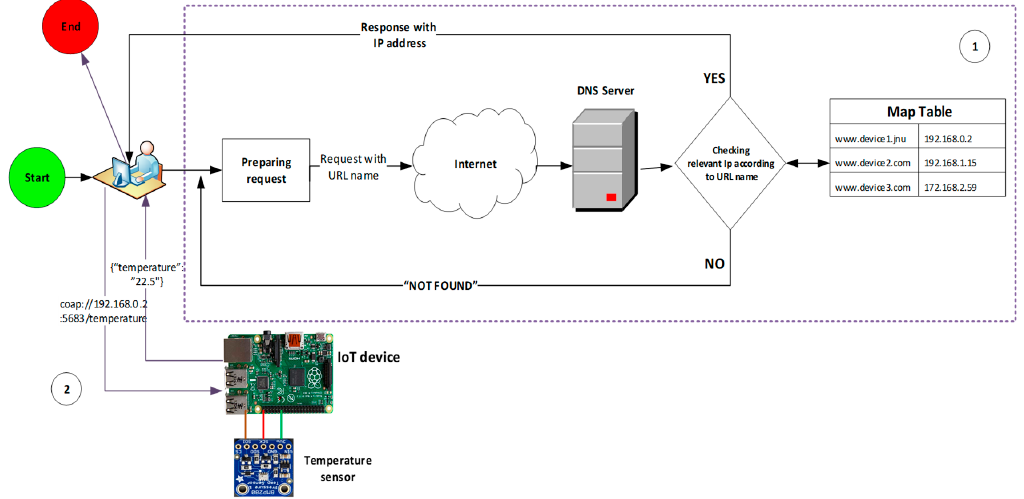
Figure 7. The general overview of the device discovery and sensing data process.